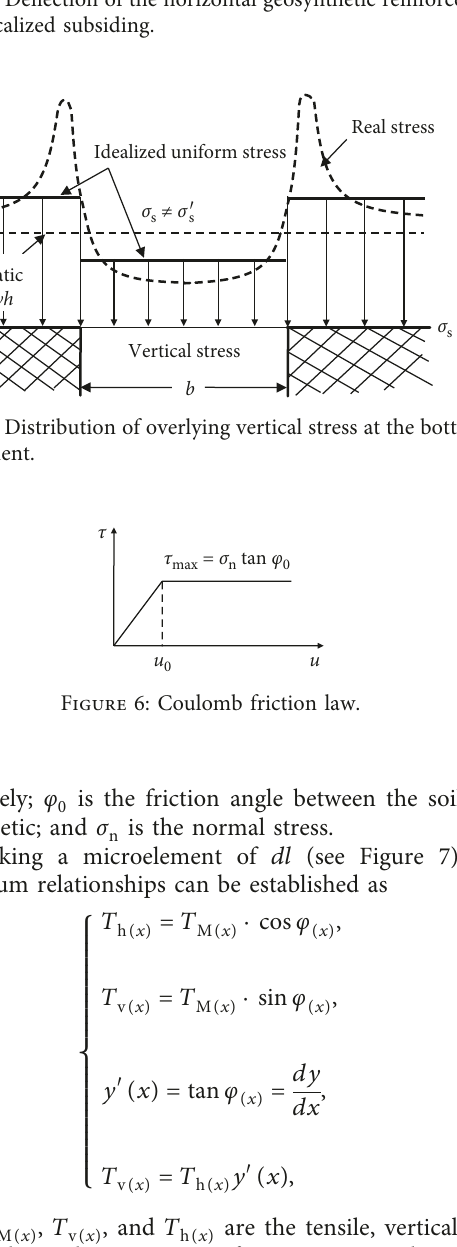
Figure 4: Deflection of the horizontal geosynthetic reinforcement due to localized subsiding.